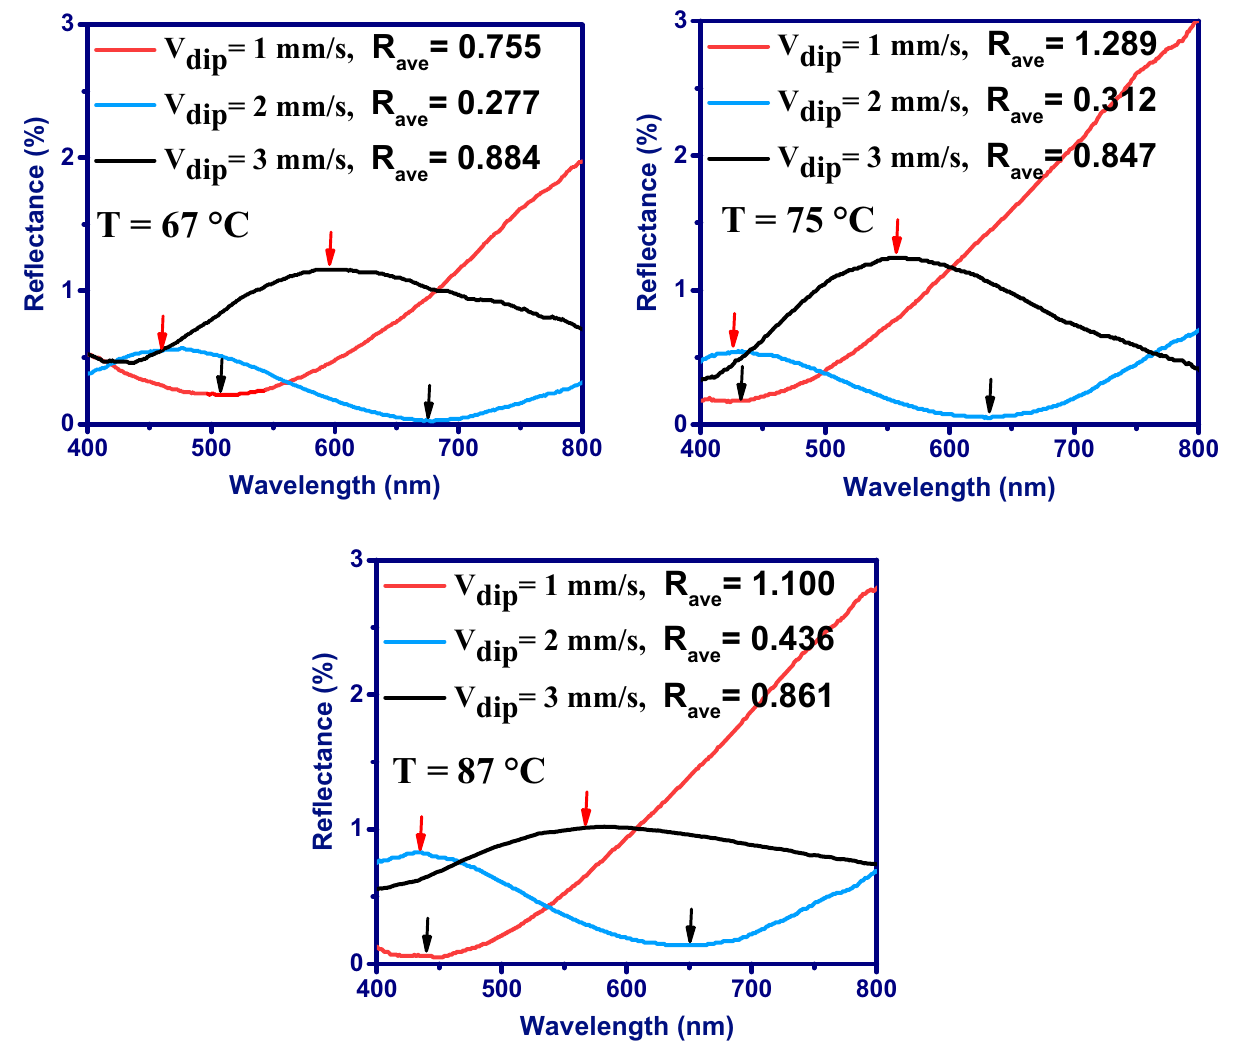
Figure 2. Reflectance spectra measured from double side coated BK7 substrates with boomerang-like Al 2 O 3 films at different dipping-withdrawing rates (V dip ) and hot-water treatment temperatures